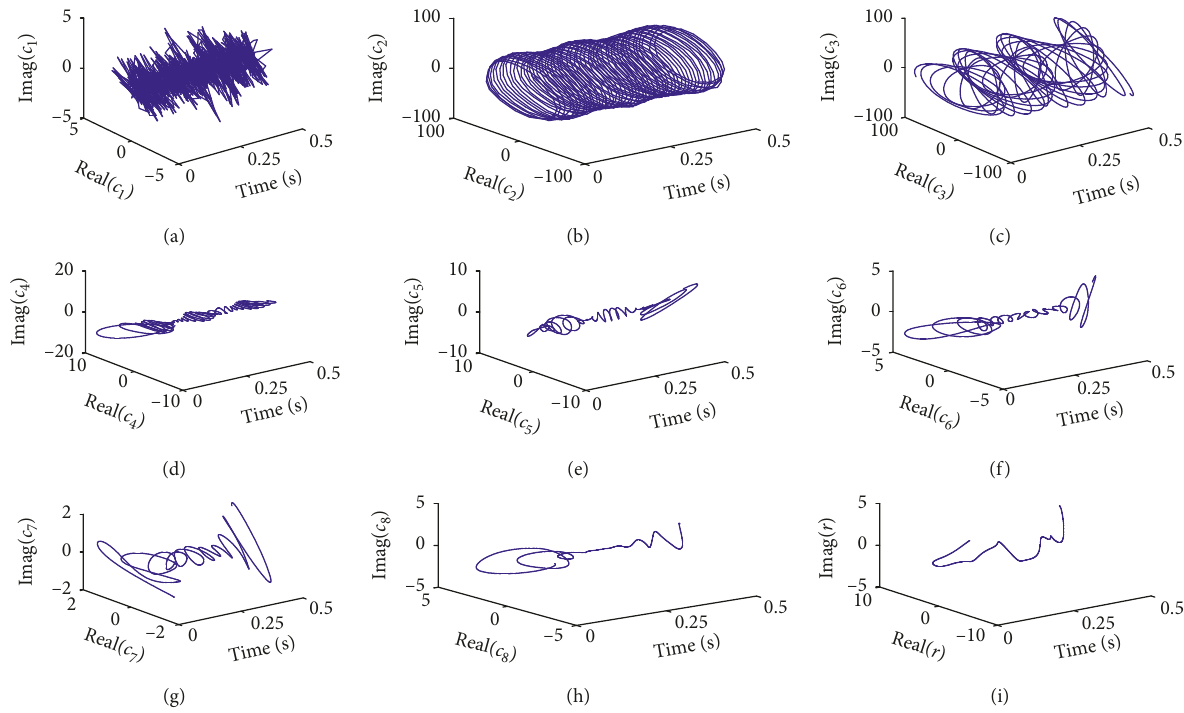
Figure 9: Decomposition results of the oil film oscillation signal using the improved BEMD method ( N